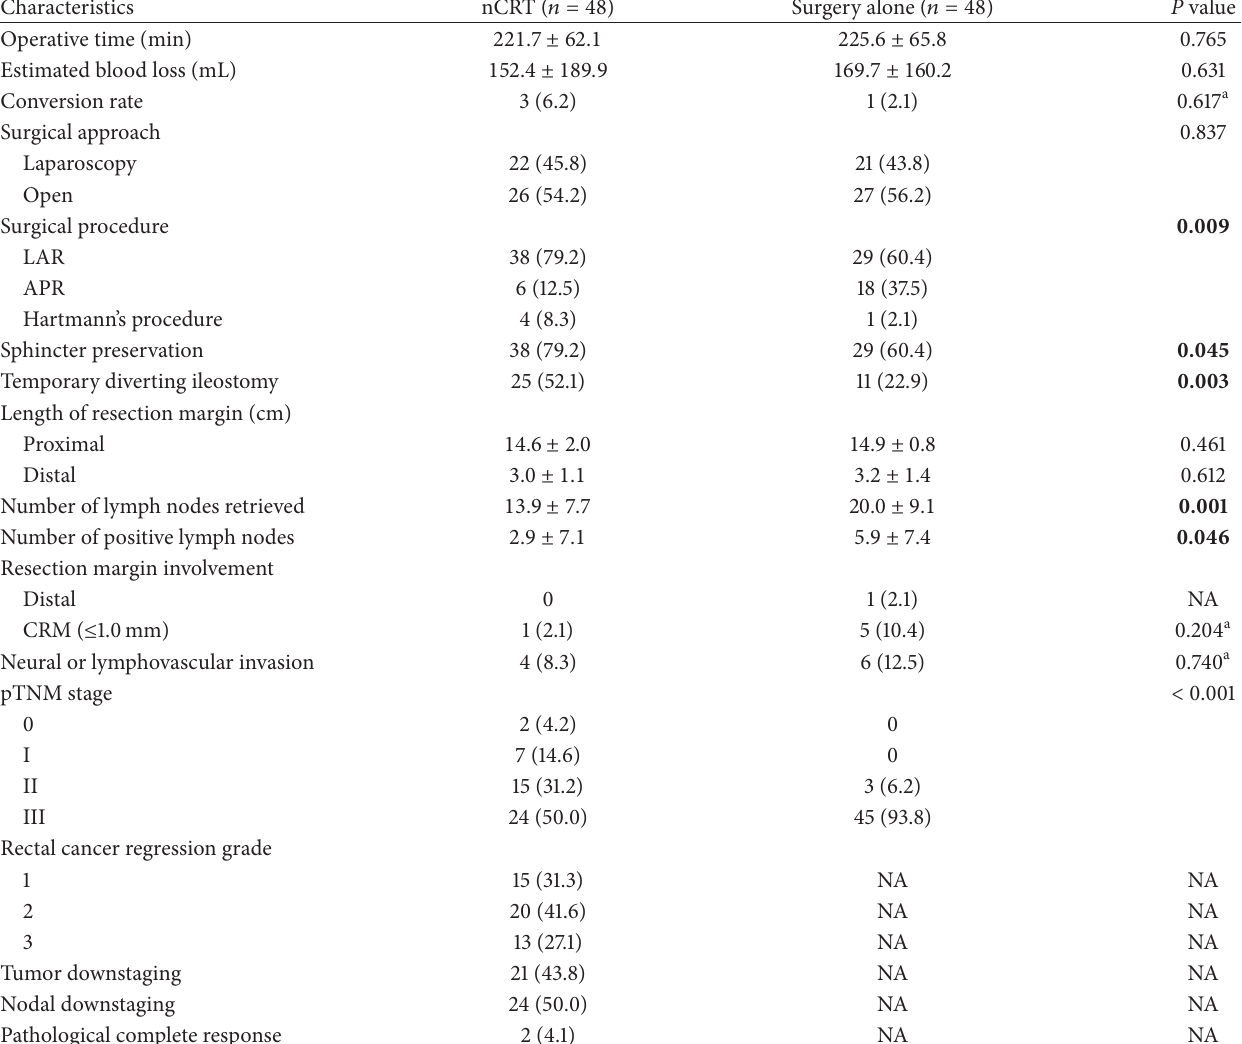
Table 2: Surgical and pathological outcomes between nCRT and surgery-alone